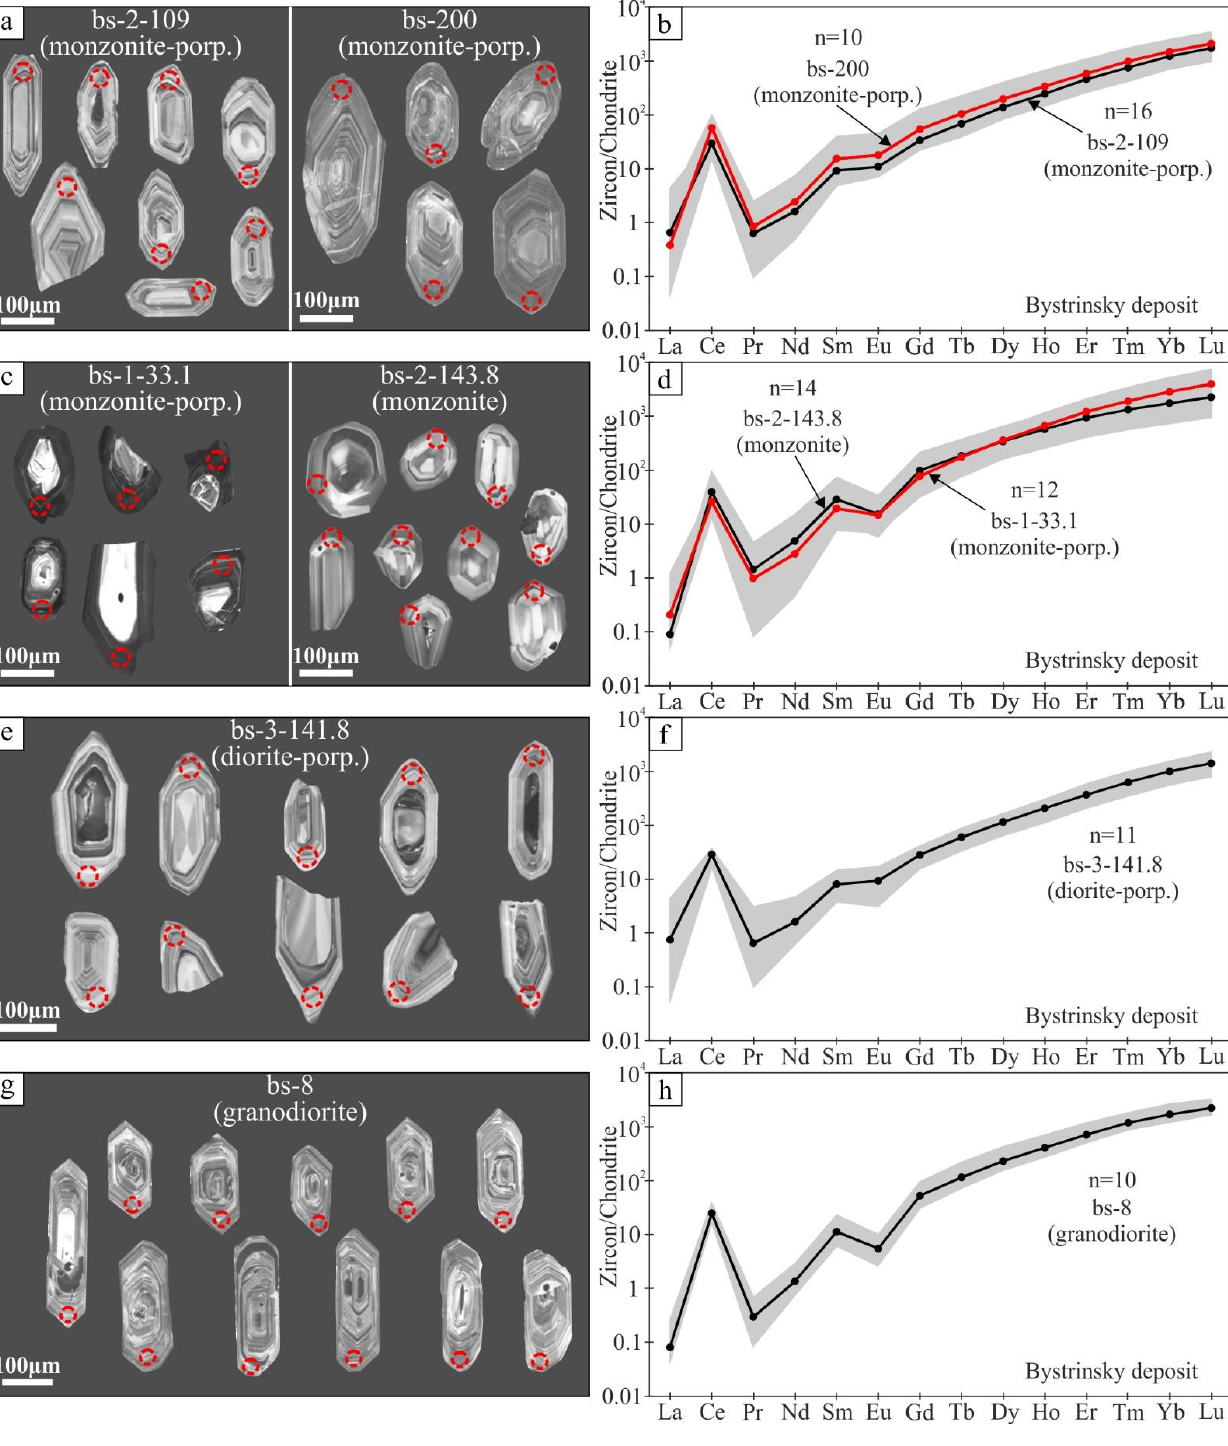
Figure 8. ( a , c , e , g ) — Cathodoluminescence (CL) images of representative zircon grains with laser spots (red circles) from the magmatic rocks of the Bystrinsky deposit: ( a , c ) — monzonite and monzonite-porphyry, ( e ) — diorite-porphyry, ( g ) — granodiorite-porphyry; ( b , d , f , h ) — chondrite-normalized REE patterns for zircons from the magmatic rocks of the Bystrinsky deposit: ( b , d ) — monzonite and monzonite-porphyry, ( f ) — diorite-porphyry, ( h ) — granodiorite.